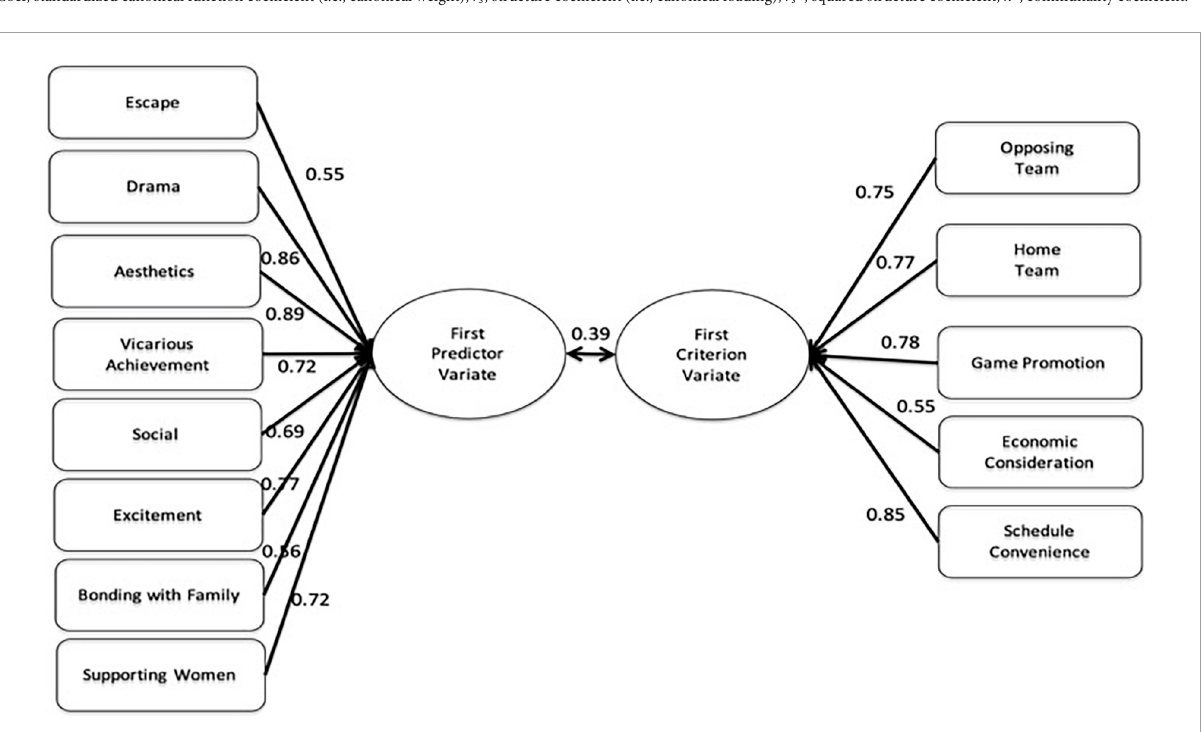
FIGURE1 Canonical functions with primary contributing factors canonical functions